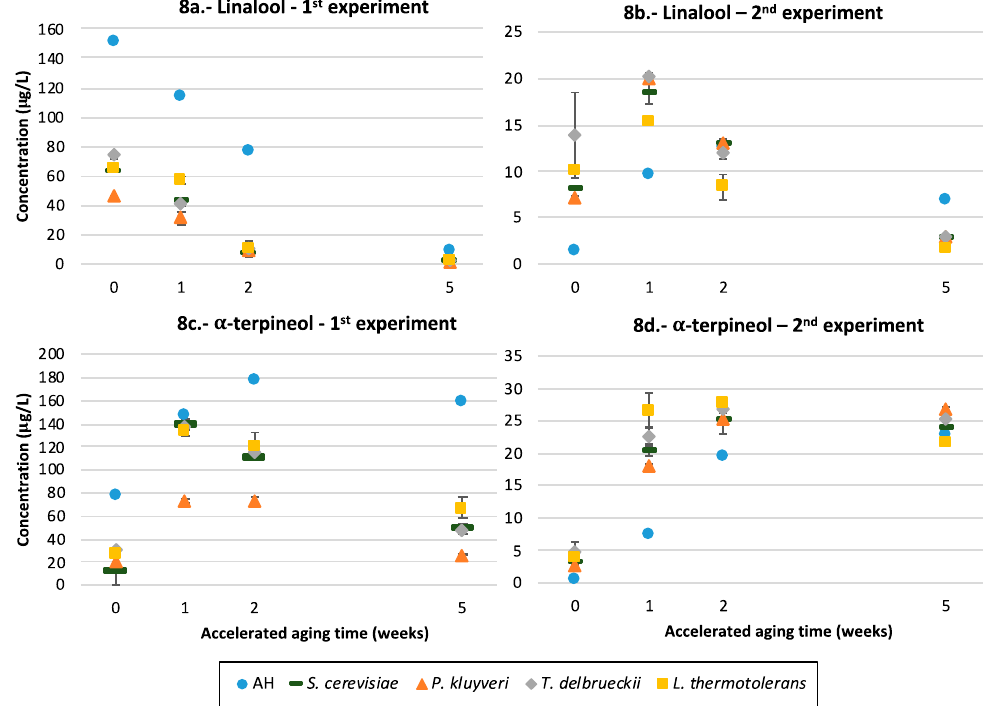
Figure 8. The linalool and α -terpineol formation in Riesling and Garnacha—the average concentration of ( a , b ) linalool and ( c , d ) α -terpineol in wines fermented with different yeast strains or unfermented controls spiked with glycosidic precursors from Riesling (1st experiment) and Garnacha (2nd experiment) and its evolution during accelerated aging.